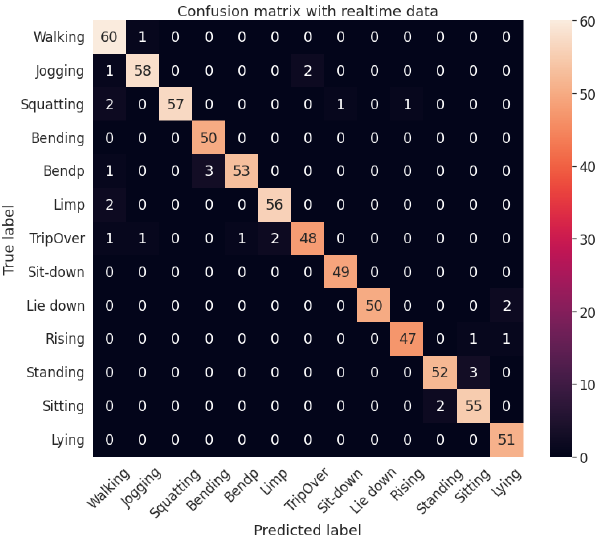
Fig 20. The confusion matrix synthesized the experimental results with the proposed recognition model embedded in a wearable